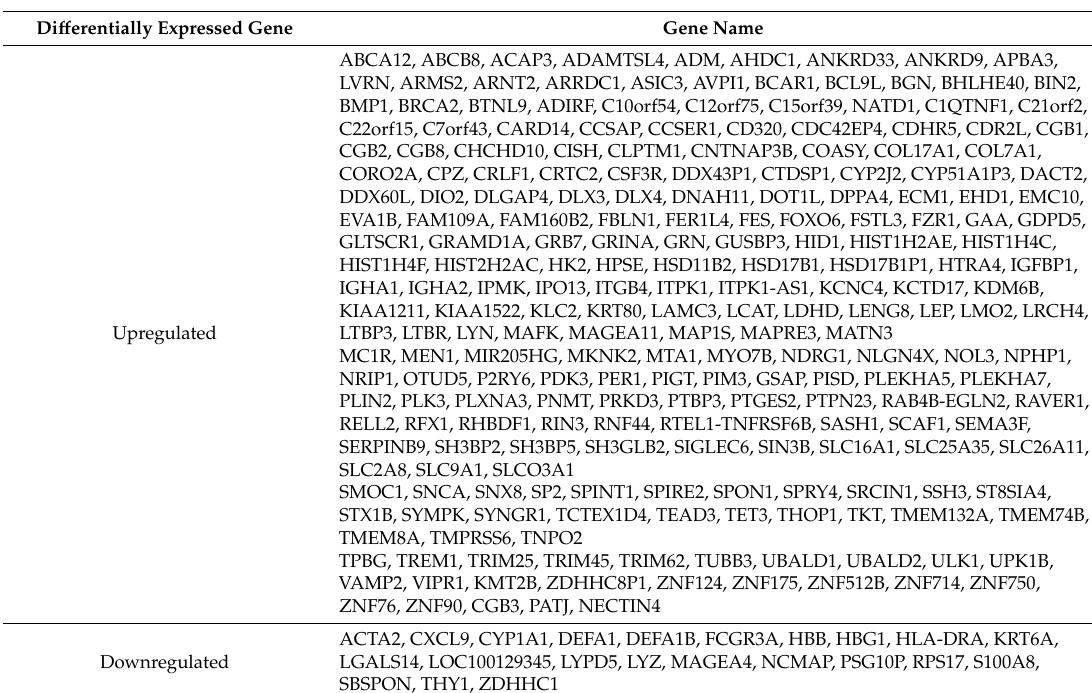
Table 2. The 250 di ff erentially expressed genes (DEGs) were identified from three profile datasets, including 228 upregulated genes and 22 downregulated genes in the placenta tissue of preeclampsia compared to normal placenta tissues.